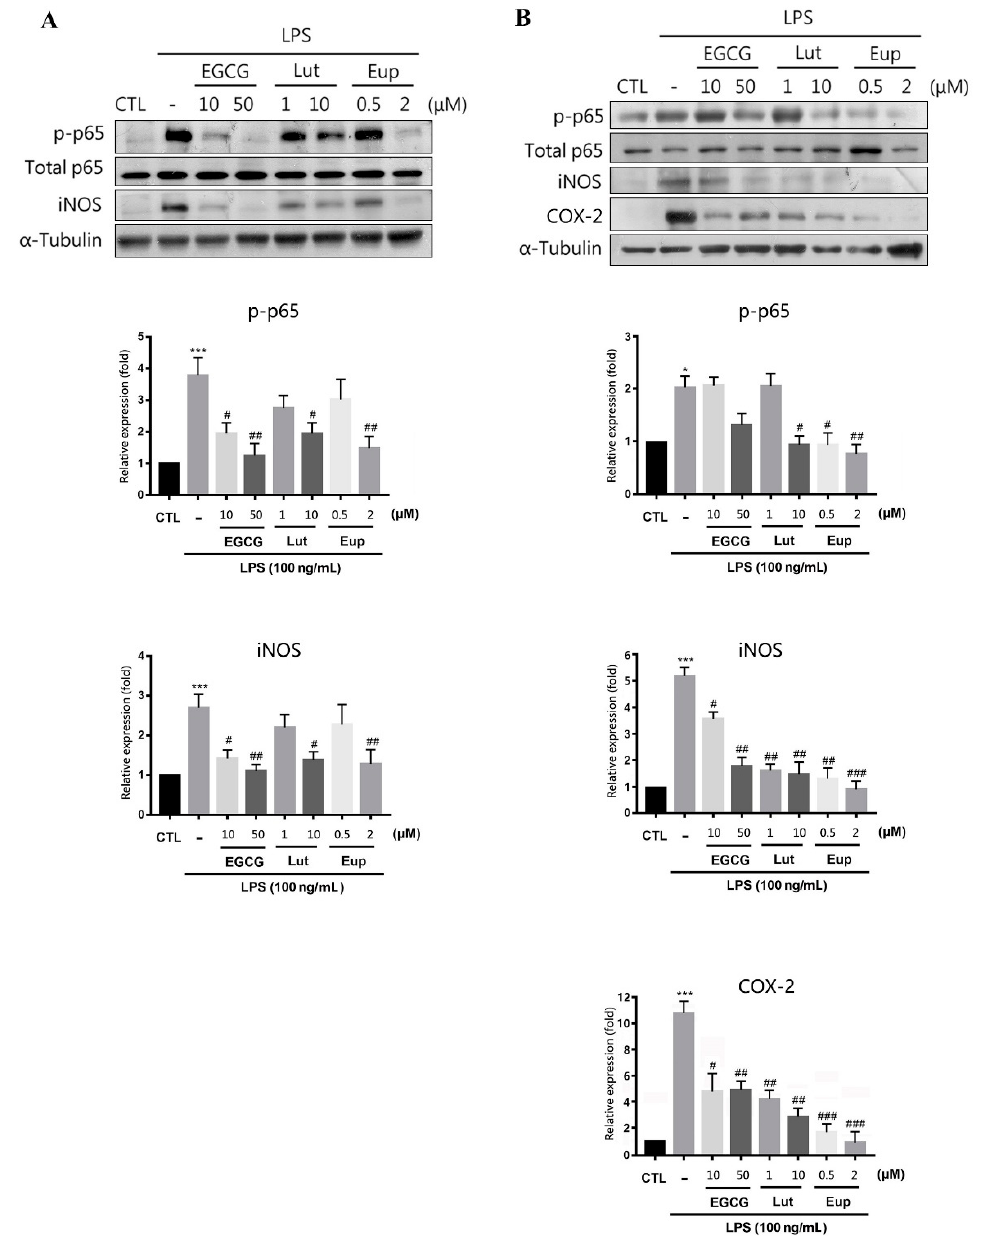
Figure 2. Eupatin significantly inhibited the phosphorylation of NF- κ B, iNOS, and COX-2 expression in lipopolysaccharide (LPS)-activated macrophages and microglia. ( A ) RAW264.7 and ( B ) BV-2 cells were treated with indicated concentrations of epigallocatechin-3-gallate (EGCG), luteolin, or eupatin for 30 min and then stimulated with LPSs (100 ng / mL) for 24 h. Western blotting of the cell lysates was performed with the indicated antibodies. The results are presented as the mean ± standard error of the mean of three independent experiments. * p < 0.05 and *** p < 0.001 for comparisons with the control group; # p < 0.05, ## p < 0.01, and ### p < 0.001 for comparisons with the group treated with LPSs.